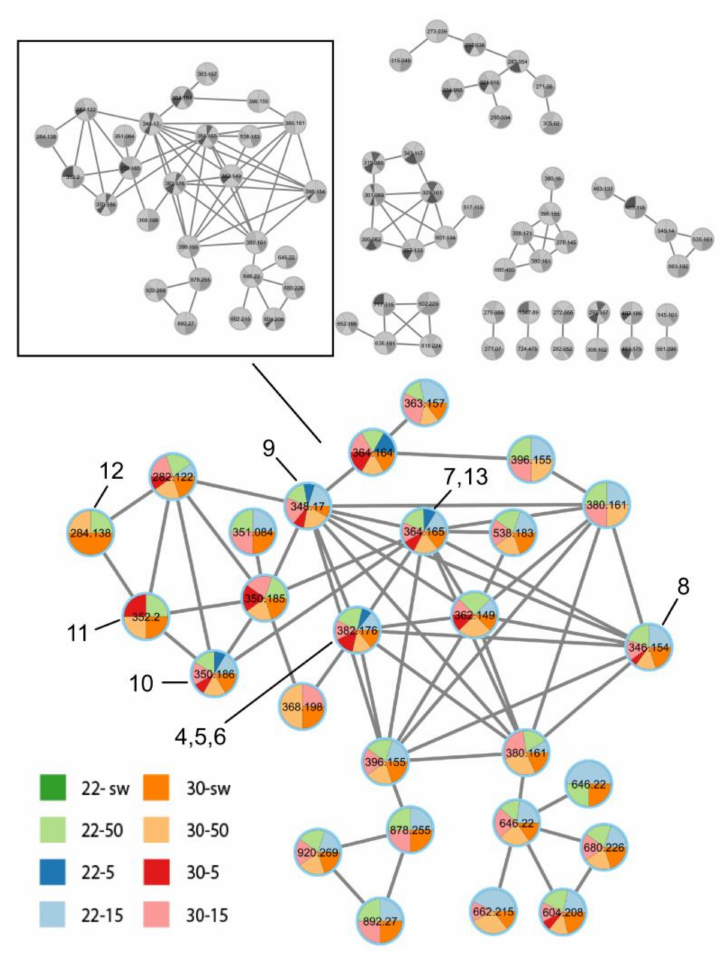
Figure 5. Feature-based molecular network (FBMN) of the extracts of strain KMM 4689. The cluster containing library hits for brevianamide-related alkaloids is highlighted. Feature identity is annotated with the results from the in-house library identification ( 4 – 11 ) and the GNPS identification ( 12 and 13 ). The precursor mass of all identified alkaloids corresponds to the [M+H] + adduct of these alkaloids. A pie chart shows the distribution of the metabolite extract according to the